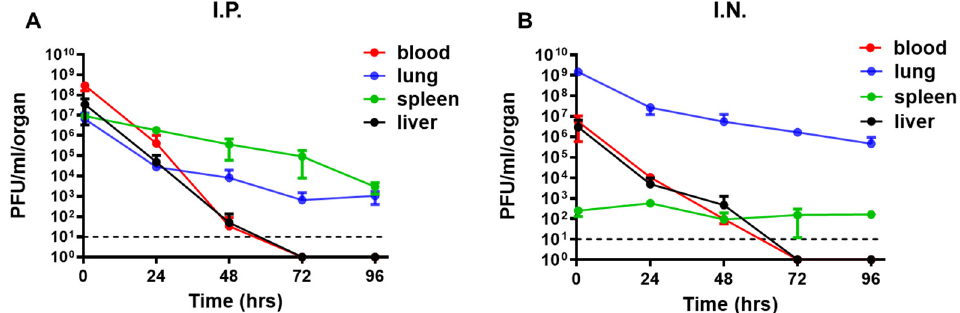
Figure 1. Pharmacokinetic analysis of ф A1122 in naive mice. A single dose of ф A1122 phage suspension (1 × 10 9 PFU) was administered to naive C57BL/6J mice, either by ( A ) IP injection (0.5 mL) or ( B ) via the IN route (35 µ L). For each administration route, n = 3 for each time point. Phage titration was performed using a spot assay test. Each dot represents the mean value in terms of PFU/organ (lung—blue dots, spleen—green dots, liver—black dots) or PFU/mL blood (red dots). Bars represent the standard deviations